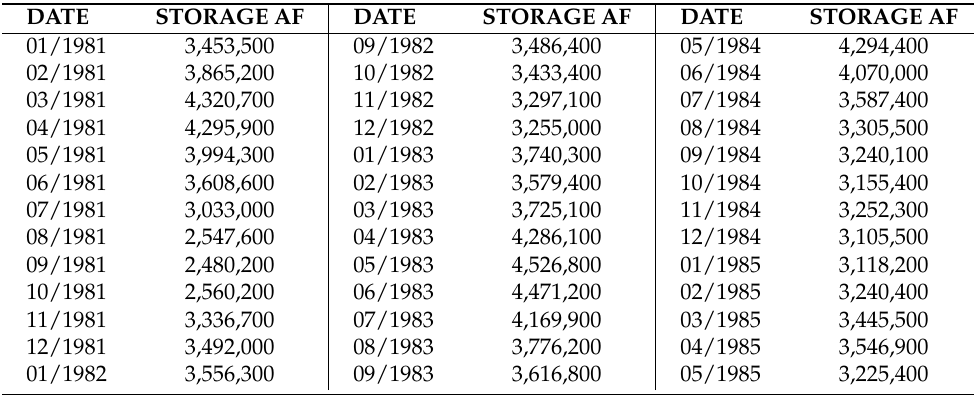
Table A1. The capacity data of Shasta reservoir from the years 1981 to